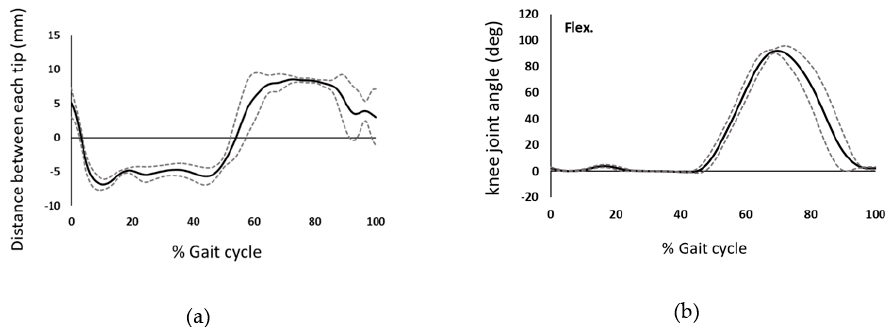
Figure 7. Kinematic data while walking. ( a ) Distance between each tip of the gear and stopper. The negative values indicate that the stopper contacts the gear to limit the rotation of the prosthetic knee joint, and the positive values indicate that the stopper is separated from the gear. ( b ) Knee joint angle. Positive angles indicate knee flexion (Flex.). The solid and dashed lines indicate the mean values and standard deviations, respectively.